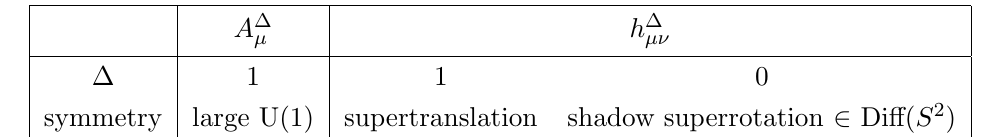
Table 1. Goldstone modes of spontaneously broken asymptotic symmetries of gauge theory and gravity. The corresponding shadow modes e A e (cid:1)=2 (cid:0) (cid:1) and h (cid:1)=1 are their own shadows, the shadow of h (cid:1)=0 (cid:22)(cid:23)